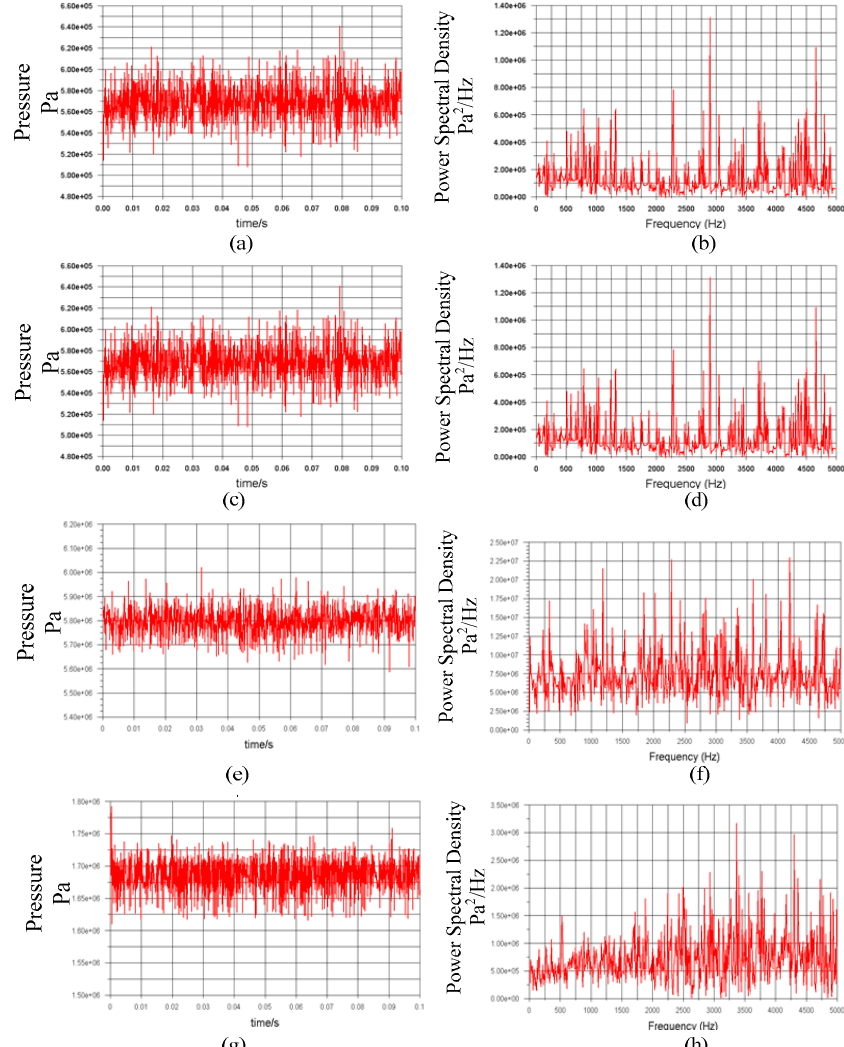
Figure 6. Pressure oscillation curves at different points on flappers. ( a ) Point 1 in the time domain. ( b ) Point 1 in the frequency domain. ( c ) Point 2 in the time domain. ( d ) Point 2 in the frequency domain. ( e ) Point 3 in the time domain. ( f ) Point 3 in the frequency domain. ( g ) Point 5 in the time domain. ( h ) Point 5 in the frequency domain.